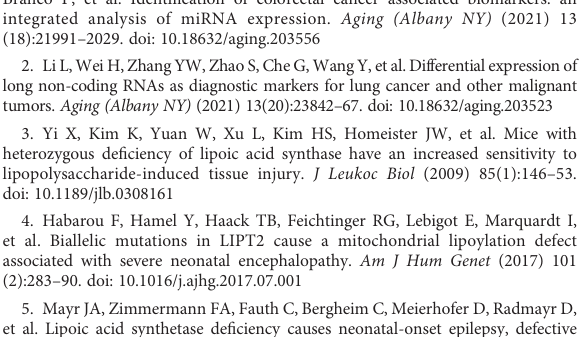
SUPPLEMENTARY FIGURE 1 GEPIA2.0 conveyed the LIAS expression between tumor tissues and normal tissues. SUPPLEMENTARY FIGURE 2 The effects of LIAS expression on the pathological stages in pan-cancer. (A – U) GEPIA2.0 portrayed the effects of LIAS expression on the pathological stages of cancer patients, including ACC, BLCA, BRCA, CESC, CHOL, COAD, DLBC, ESCA, HNSC, KICH, KIRP, LIHC, LUSC, READ, OV, SKCM, STAD, TGCT, THCA, UCEC and PAAD. SUPPLEMENTARY FIGURE 3 The prognostic values of LIAS expression in three kinds of cancers. (A – C) The Kaplan-Meier plotter displayed the effects of LIAS expression on the prognostic values (OS, DMFS, PPS, RFS, PFS and FP) in three cancers, including breast cancer, ovarian cancer and lung cancer. SUPPLEMENTARY FIGURE 4 The methylation levels of LIAS in several cancers. (A – U) The UALCAN database revealed the methylation levels of LIAS in CESC, CHOL, COAD, KIRP, LIHC, PCPG, READ, STAD, THYM, BLCA, BRCA, ESCA, LUSC, PAAD, PRAD, TGCT, THCA, UCEC, HNSC, GBM and SARC, respectively. SUPPLEMENTARY FIGURE 5 The correlation between expression levels of LIAS and immune cell in fi ltration. (A – C) The TIMER2.0 database the relationship between LIAS expression and immune in fi ltration of neutrophil, NK cell and monocyte.